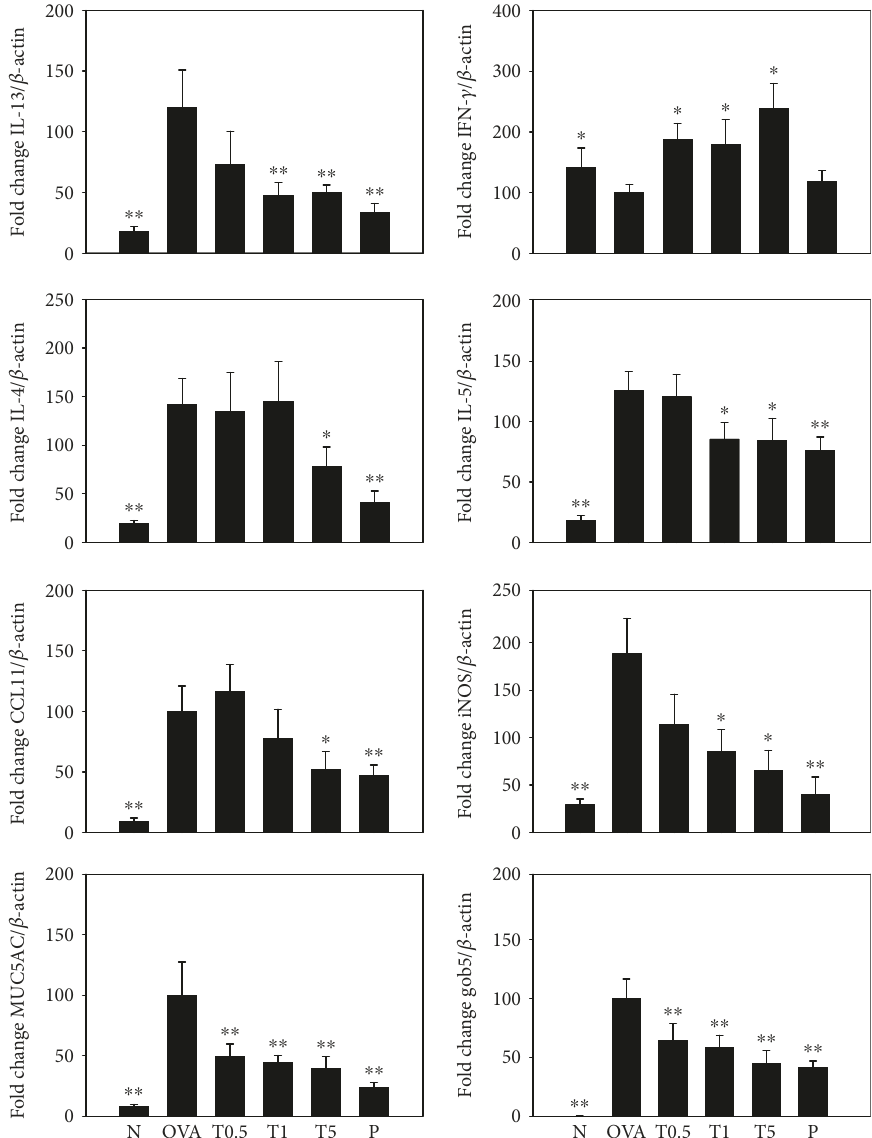
Figure 5: E ff ects of tomatidine on gene expression in the lung. IL-4, IL-5, IL-13, IFN- γ , CCL11, iNOS, MUC5AC, and gob5 expression was determined using real-time RT-PCR. Data are presented as means ± SEM. ∗ P < 0 05 , ∗∗ P < 0 01 compared to OVA